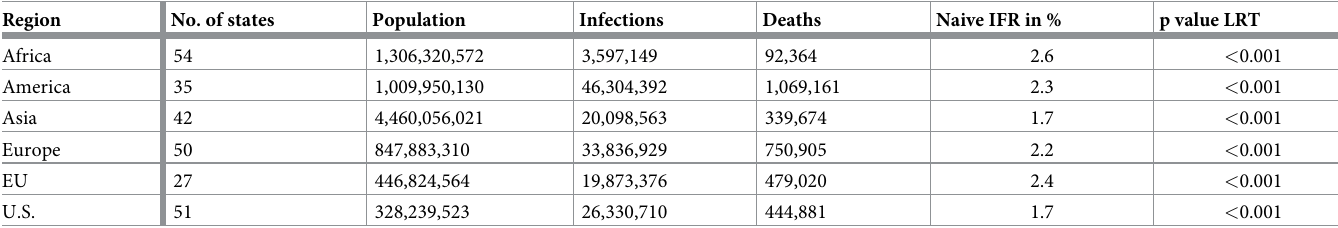
Table 1. Descriptive overview of COVID-19 data for different geographic